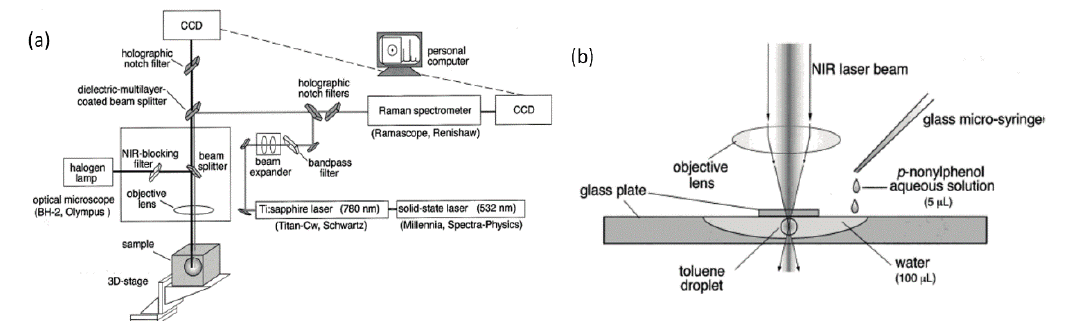
Figure 7. One of the earliest typical LTRS experimental schematics for ( a ) the near-infrared Raman trapping system; and ( b ) the optical arrangement for the sample cell [52] (With permission from ACS